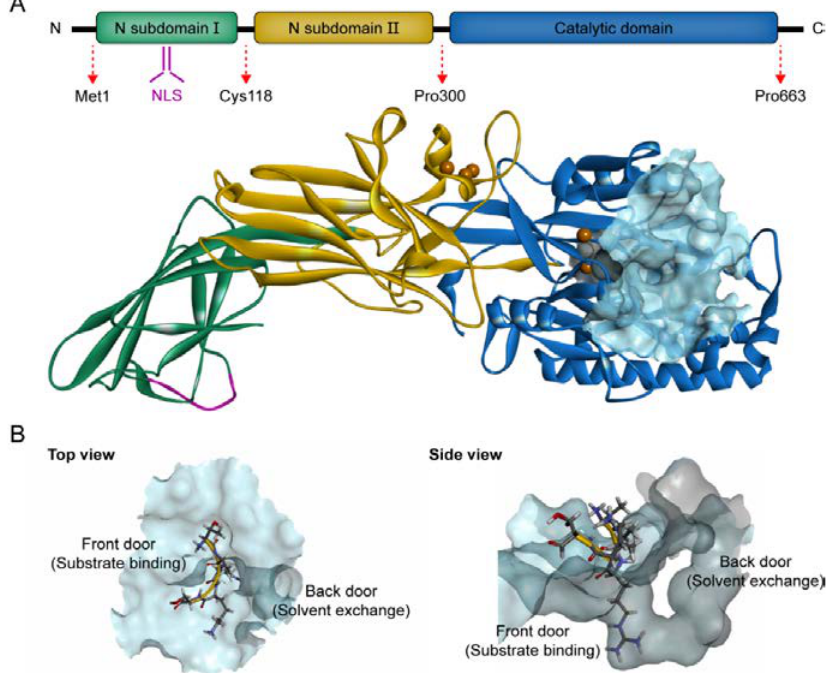
Figure 3. The three-dimensional structure of PAD4. ( A ) Calcium-bound PAD4 monomer structure (PDB: 1WD9). The NLS is shown in magenta, and the active pocket is shown in light blue. ( B ) The N-terminal tail of histone H3 occupies the PAD4 active pocket “front door” (PDB: 2DEW).